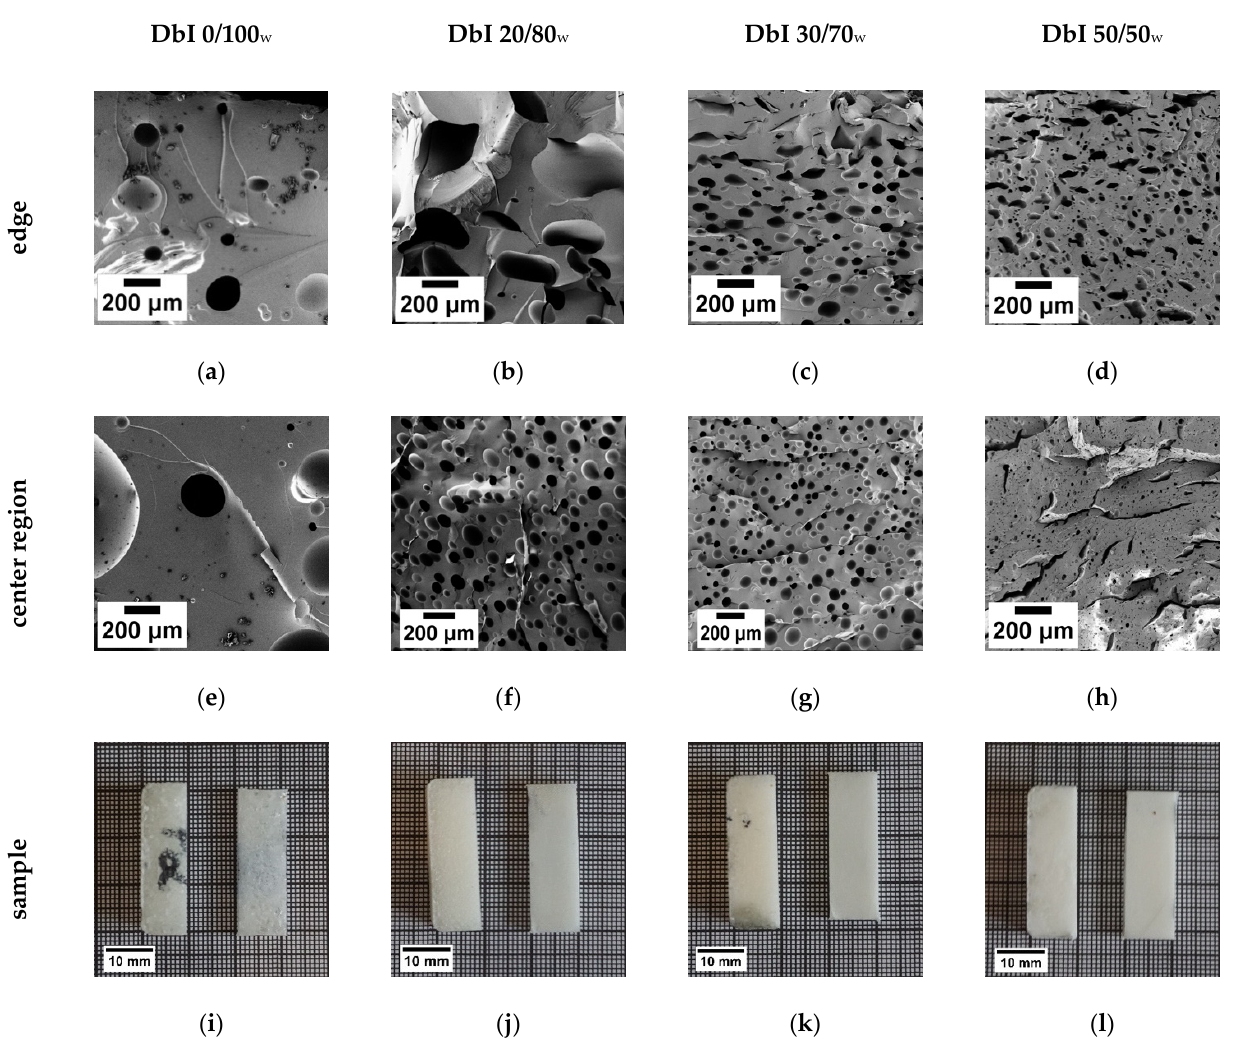
Figure 5. SEM pictures of the DbI systems with blend ratios of 0/100 w ( a , e , i ), 20/80 w ( b , f , j ), 30/70 w ( c,g , k ) and 50/50 w ( d , h , l ). The edge region is presented in the images ( a – d ), the core region in ( e , f ) and the foam sample in ( i – l ) from top side ( left ) and cross section ( right ).